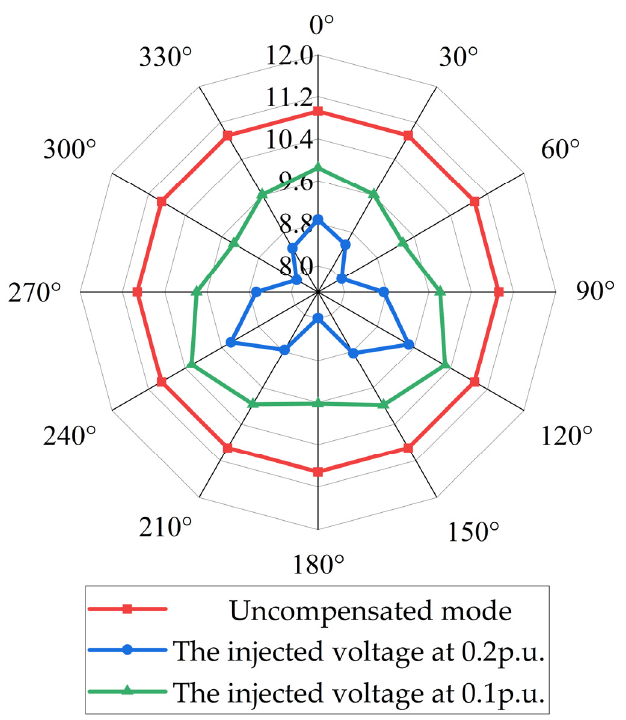
Figure 5. The short-circuit currents for single-phase-to-ground faults.